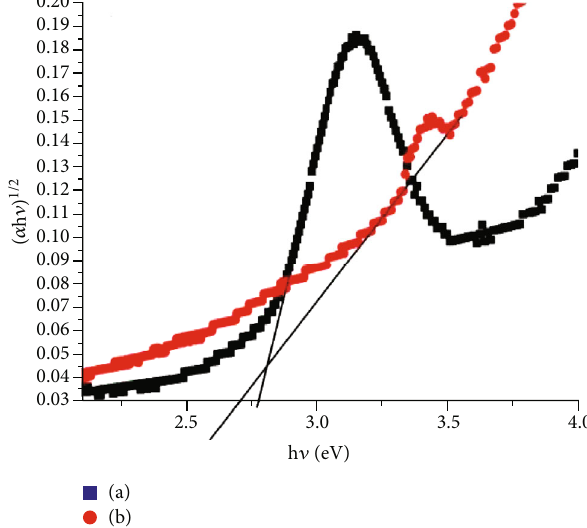
NPs (a) before and (b) after 2